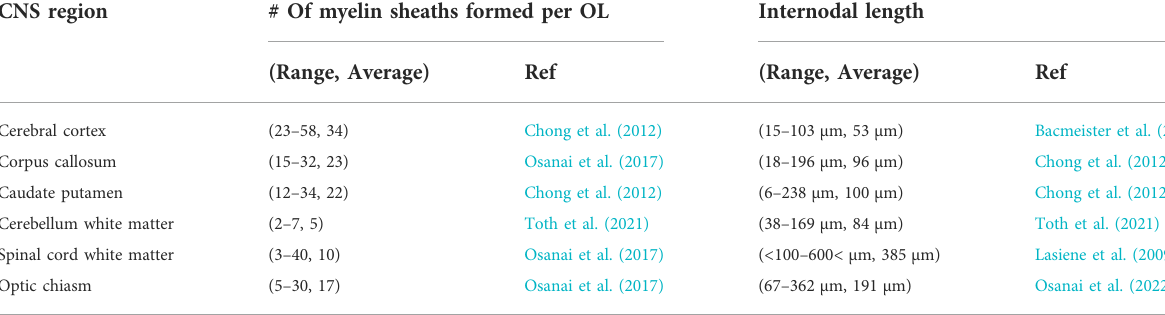
TABLE 2 The number of myelin sheaths per oligodendrocyte and myelin internodal length in each CNS